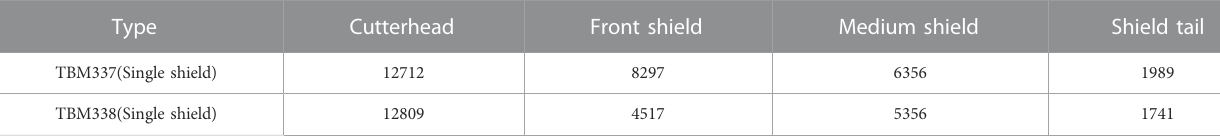
TABLE 7 TBM weight distribution